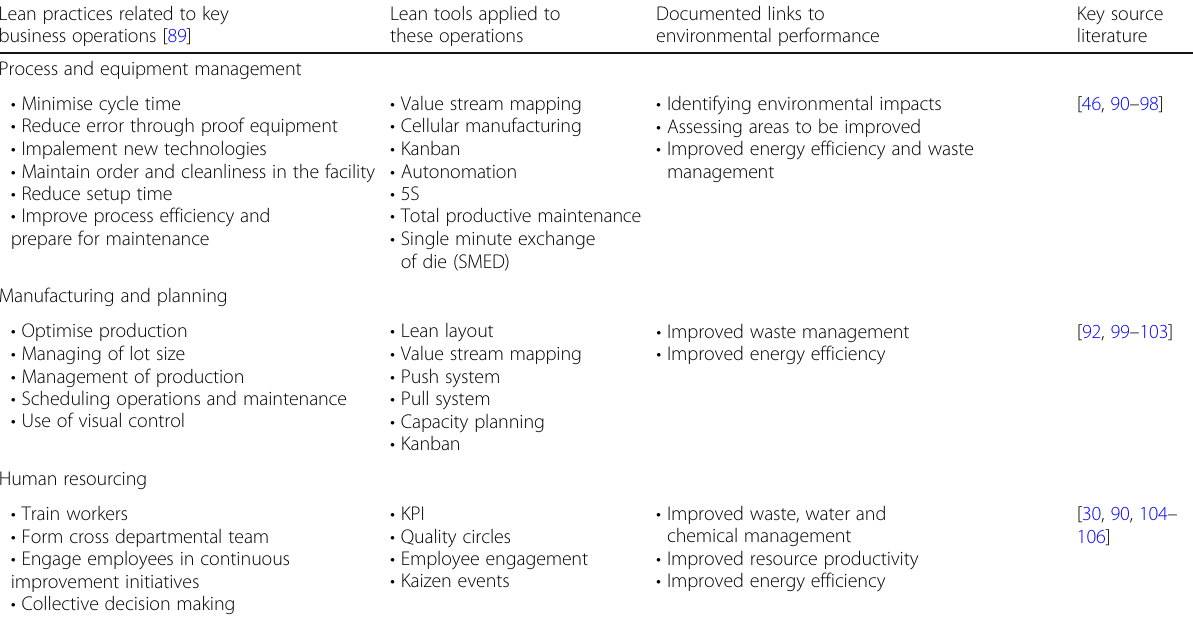
Table 1 Lean tools in manufacturing, and their links to improved environmental performance Lean practices related to key business operations